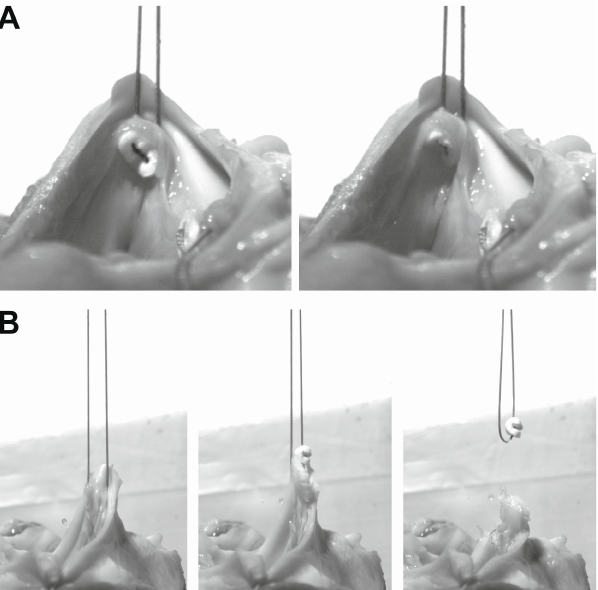
Figure 3. Representative illustration of pledget behavior under traction. Still images were taken from the high-speed recordings. ( A ) Moment of “cut-in”. As soon as the critical force is reached, the subannular pledget suddenly migrates into the tissue. ( B ) Moment of “tear-out”. At a more distant force level, the annulus tears and releases the pledget with a jerk.